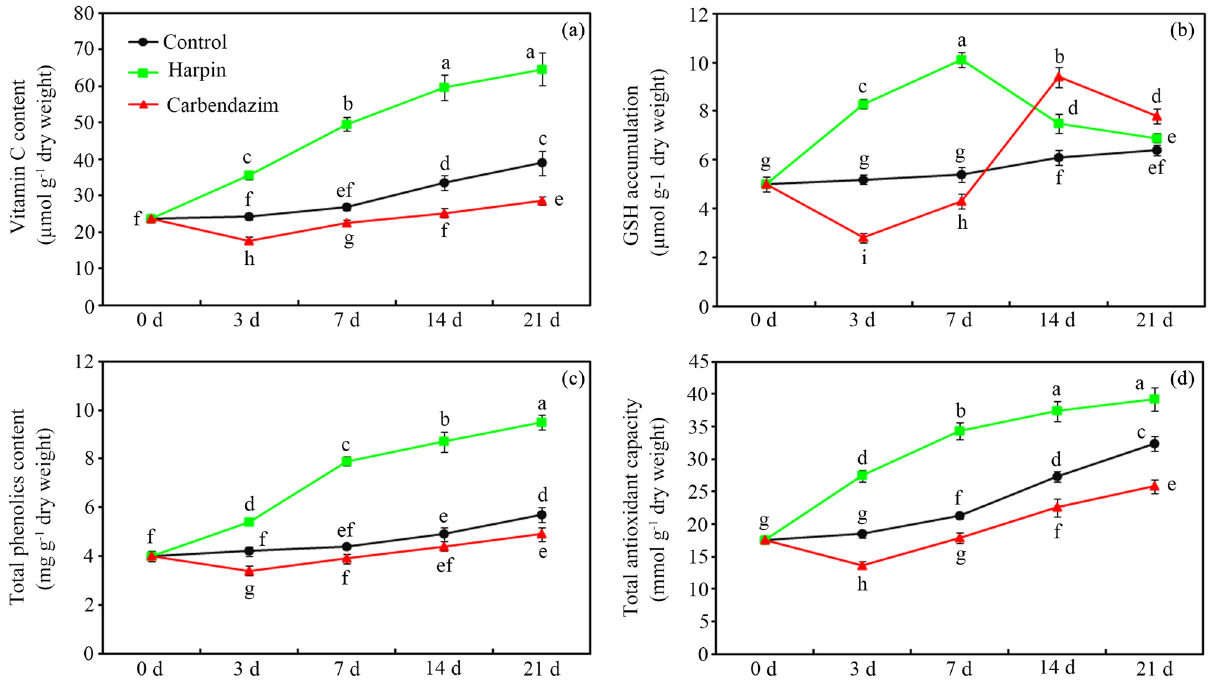
Figure 2: Antioxidant content in young leaves. E ff ects of harpin ( 30 mg L − 1 ) and carbendazim ( 1,000 mg L − 1 ) on vitamin C ( a ) , GSH ( b ) , total phenolics ( c ) , and total antioxidant capacity ( d ) in young leaves after treatment for 0, 3, 7, 14, and 21 days. Bars represent the standard deviations of the means ( n = 3 ) . Numbers with the same letter were not signi fi cantly di ff erent ( p < 0.05 ) . GSH, reduced